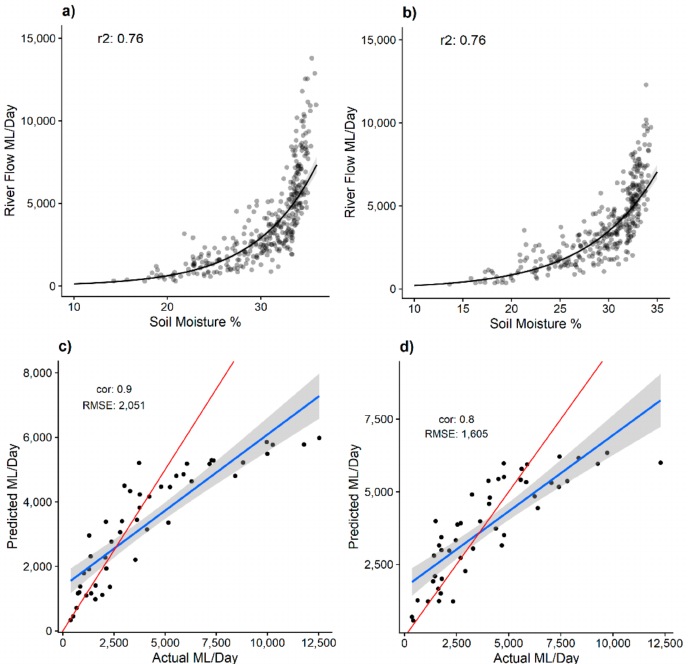
Figure 3. Regression of mean monthly river flow against modelled soil moisture for the ( a ) Franklin River and ( b ) Davey River. Model validation plots of river flow based on monthly BARRA-TA catchment surface layer soil moisture for ( c ) Franklin River and ( d ) Davey River for the 2015–2018 validation period. One to one validation line is shown in red, and modelled line in blue, with standard errors. Validation data points are shown in black. Shaded areas represent 95% model confidence